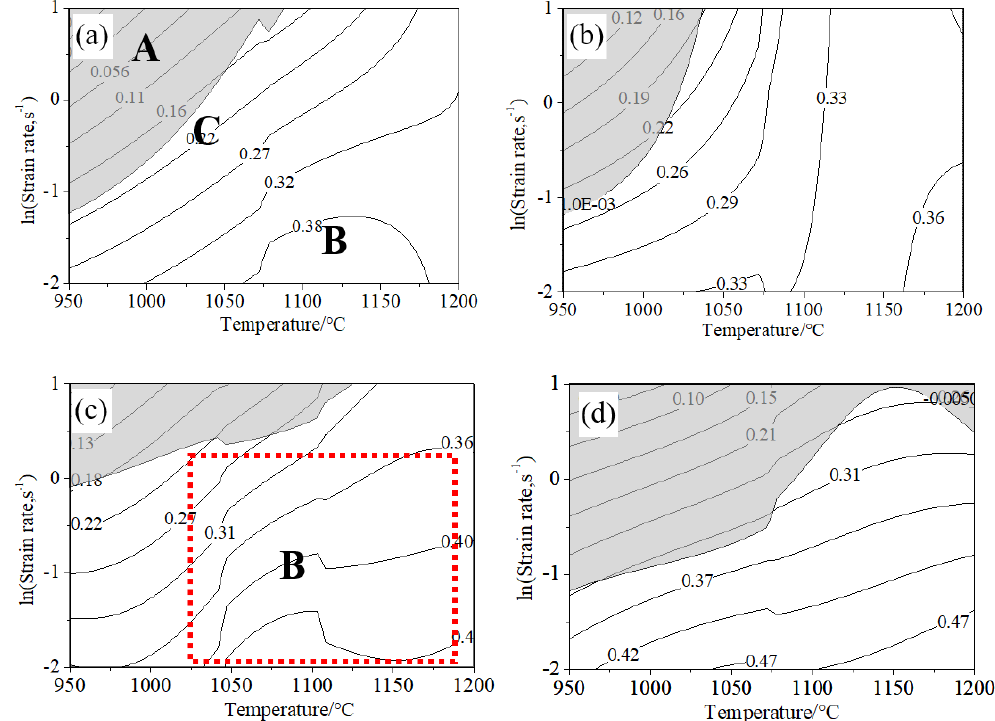
Figure 16. Processing maps for nickel-based super-alloy of 2W at true strains of ( a ) 0.2, ( b ) 0.4, ( c ) 0.6, ( d ) 0.8. The contour values is power dissipation efficiency expressed in pct.